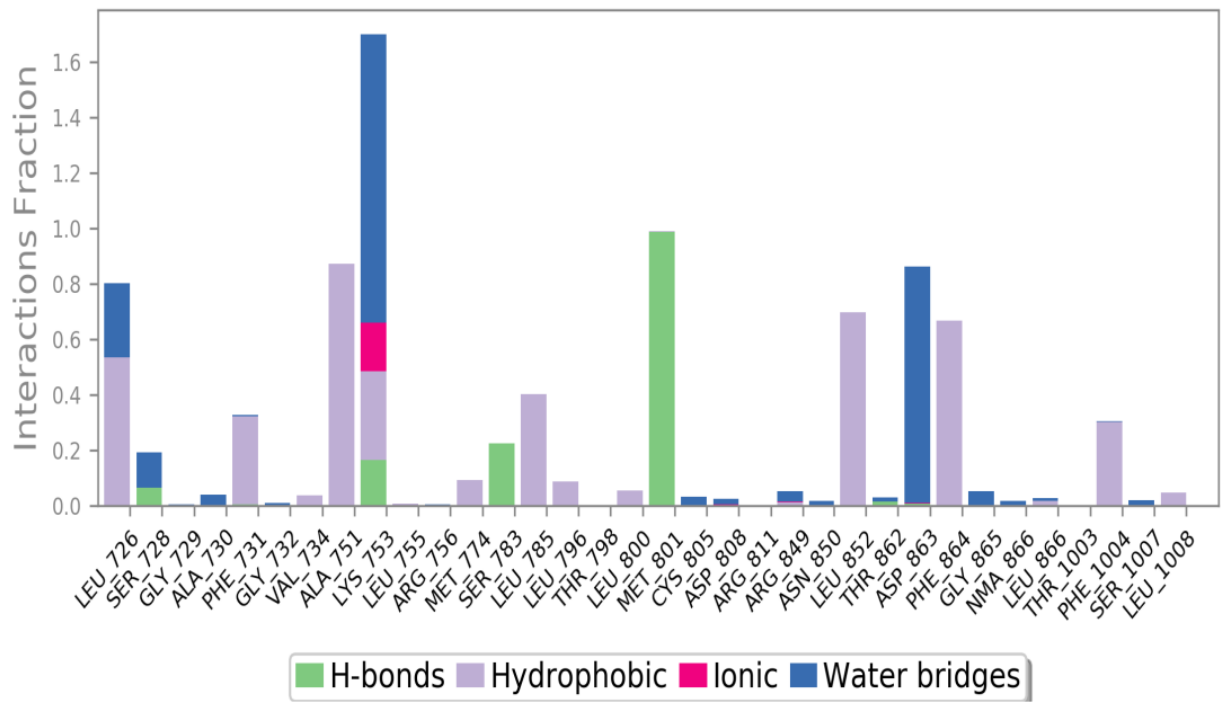
Figure 8. The histogram of 6j -3RCD contact throughout the trajectory.